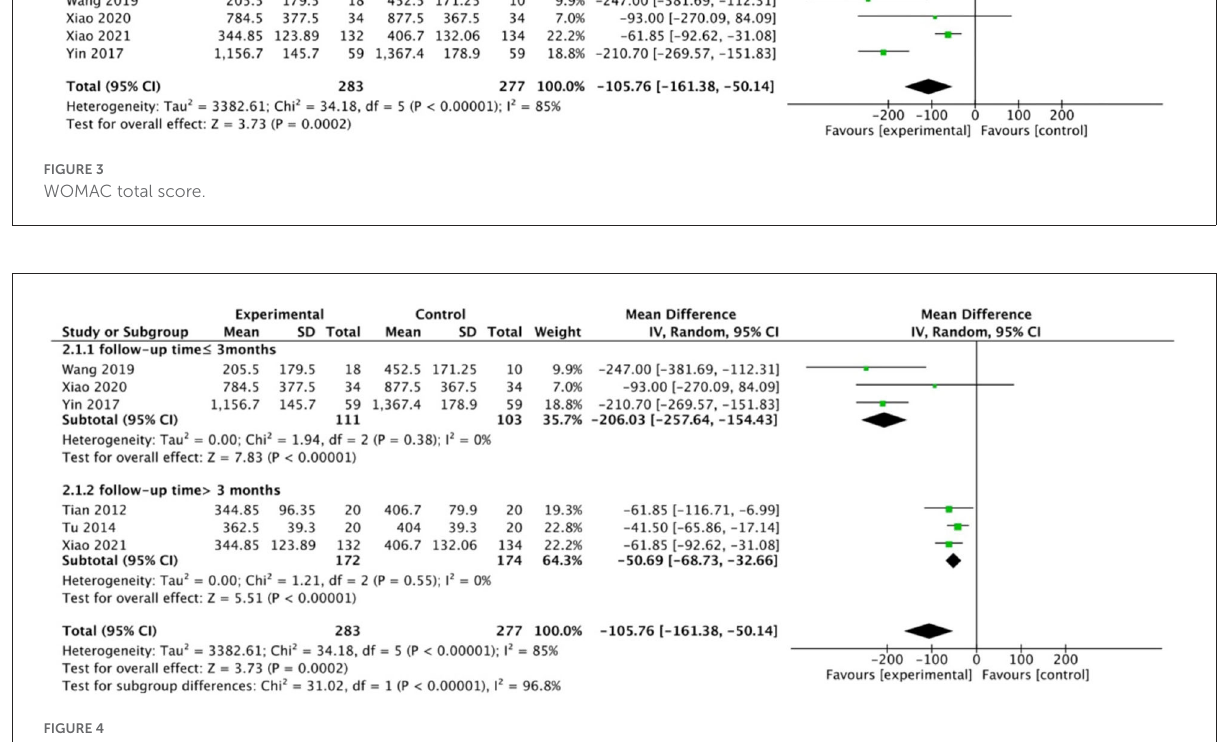
FIGURE4 Subgroup analysis by follow-up